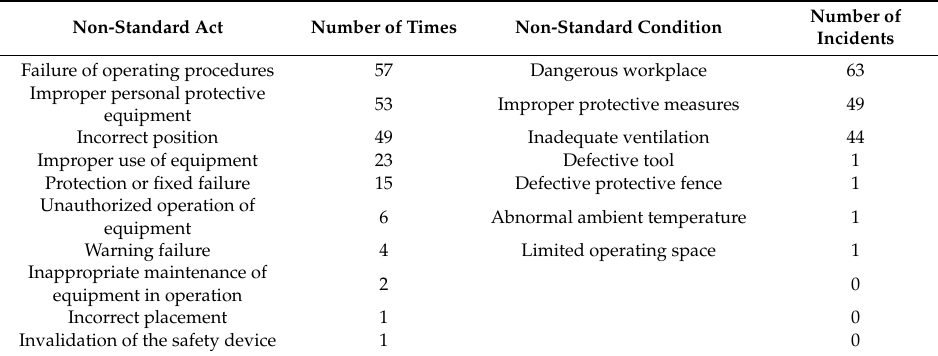
Table 4. Non-standard acts and non-standard conditions analyzed in this